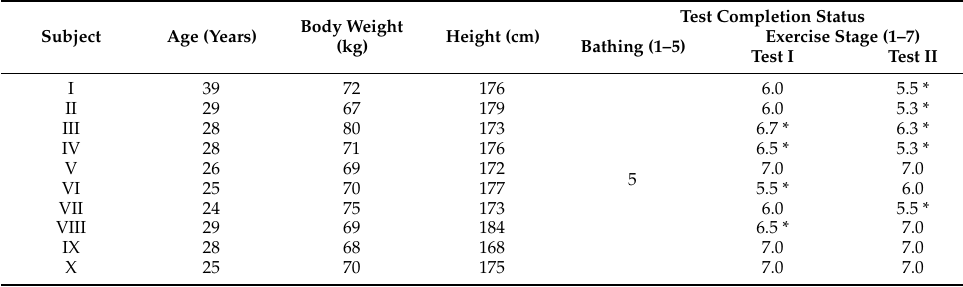
Table 3. Biometric information of subjects and test completion